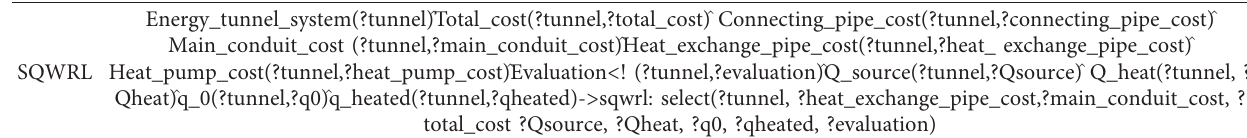
Table 7: SQWRL rule for selecting all the information of design schemes.